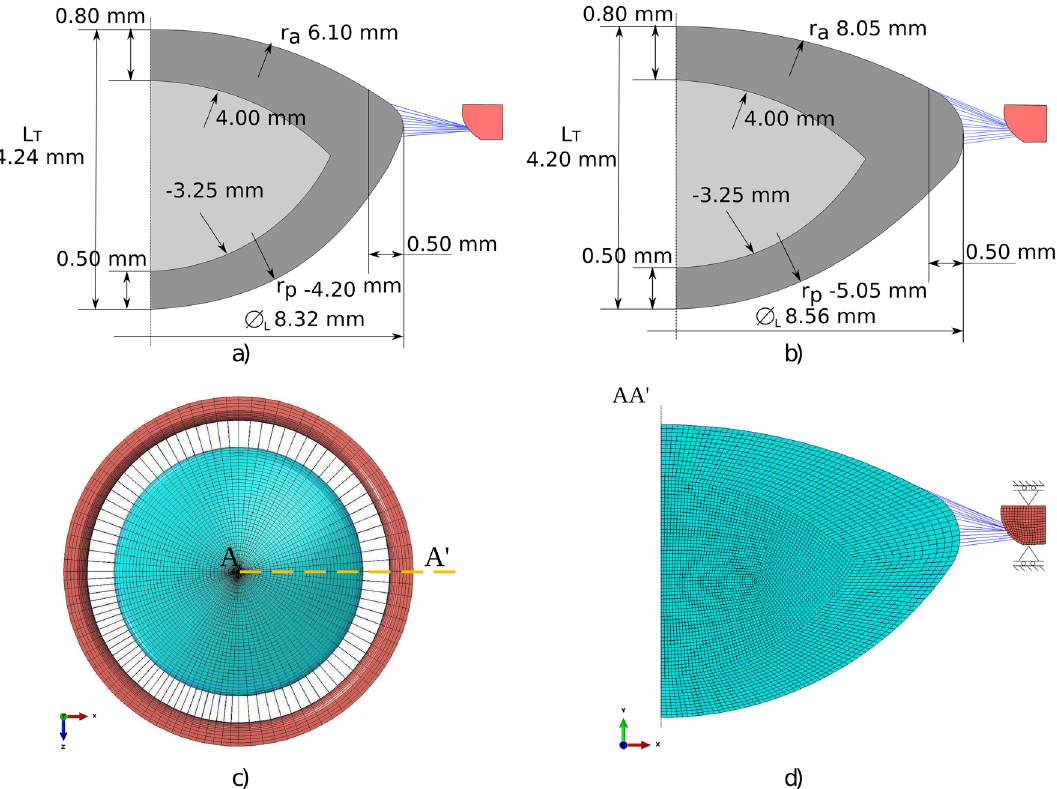
Figure 1. The dimensions of the 17-year-old ( a ) and 29-year-old ( b ) lens geometry. The nucleus is depicted in light grey, whilst the cortex is in dark grey. A plane ( c ) and profile ( d ) view of the FE model for the 29 y/o subject is presented. Zonules and part of the ciliary body ring are depicted in blue and red,